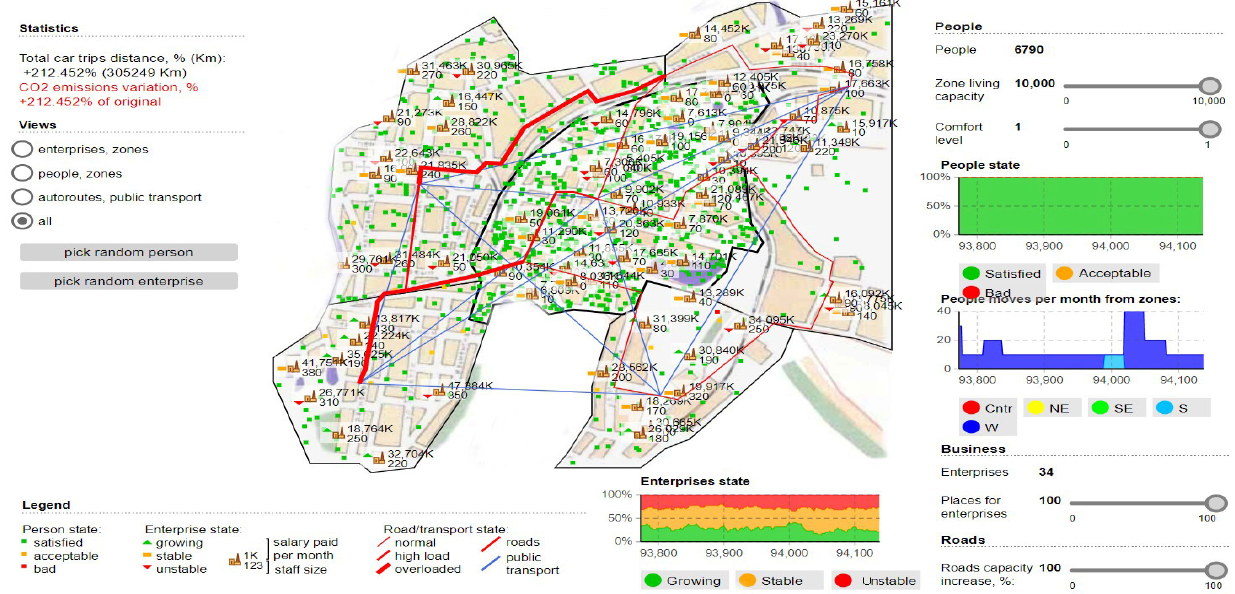
Figure 5. Simulative scenario in which the ACO model are presented in relation to traffic densities and transit capacity in relation to the capacity of areas and nodes through which transportation vehicles can pass.